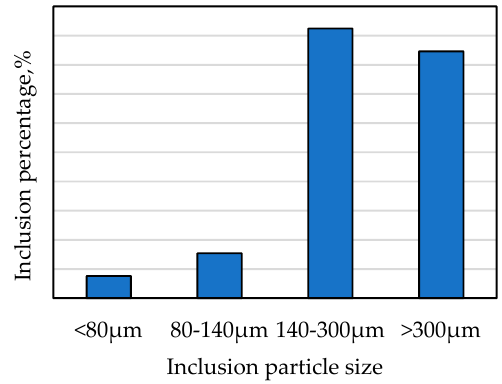
Figure 3. Large inclusions in Sample Y at 20× magnification: ( a ) <80 μ m; ( b ) 80~140 μ m; ( c ) 140~300 μ m; ( d ) >300 μ m.